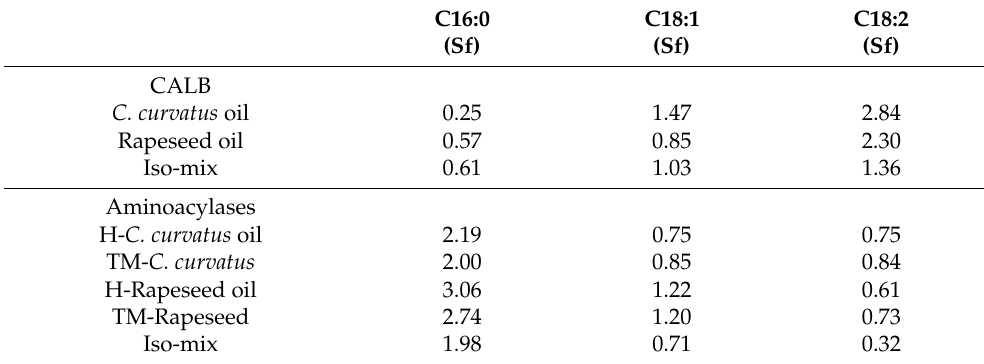
Table 10. Specificity factor of CALB and aminoacylases towards the 3 major fatty acids of oils and tailor-made